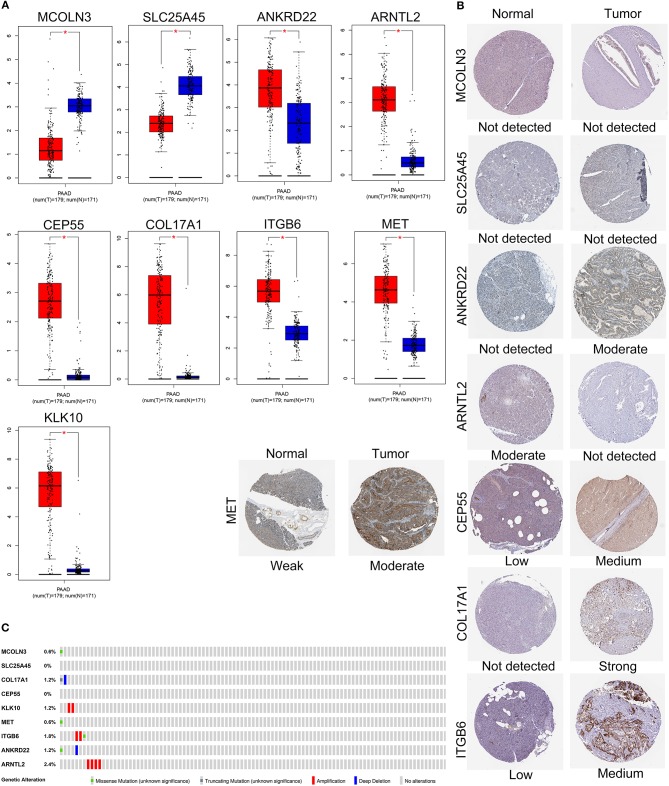
Validation of expression and alteration of the nine genes in pancreatic cancer. (A) The mRNA expression levels in TCGA pancreatic cancer tumor tissue and matching normal tissue from data of TCGA and GTEx. Data was obtained from the GEPIA (http://gepia.cancer-pku.cn/). (B) The representative protein expression of the nine genes in pancreatic cancer tumor tissue and normal tissue. Data was obtained from the human protein atlas (https://www.proteinatlas.org/). (C) Genetic alterations of the nine genes in pancreatic cancer. Data was obtained from the cBioportal (https://www.cbioportal.org/).